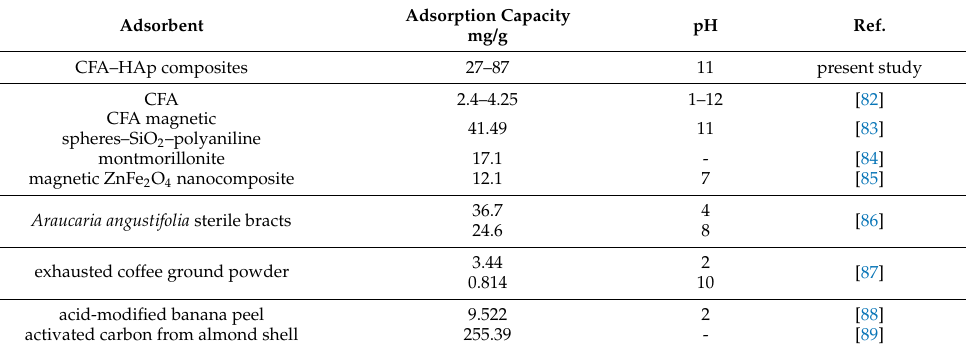
Figure 3. Freundlich ( a ), Langmuir ( b ), and Redlich–Peterson ( c ) isotherm of RB adsorption on the CFA–HAp2 composite. Table 6. Comparison of the adsorption capacities of various adsorbents for